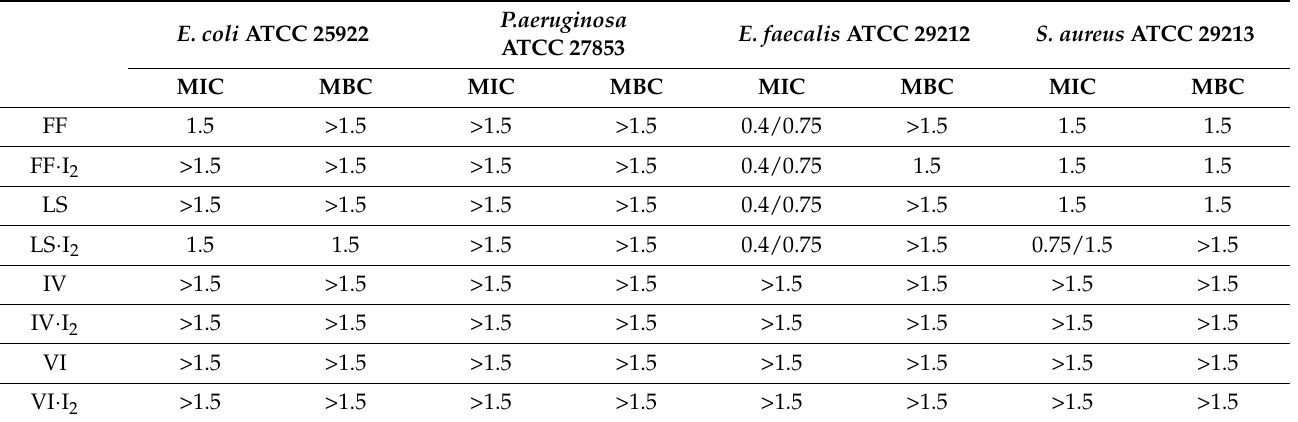
Table 1. Antibacterial activity of supramolecular dipeptides against reference strains. MIC in mg/mL. E. coli ATCC